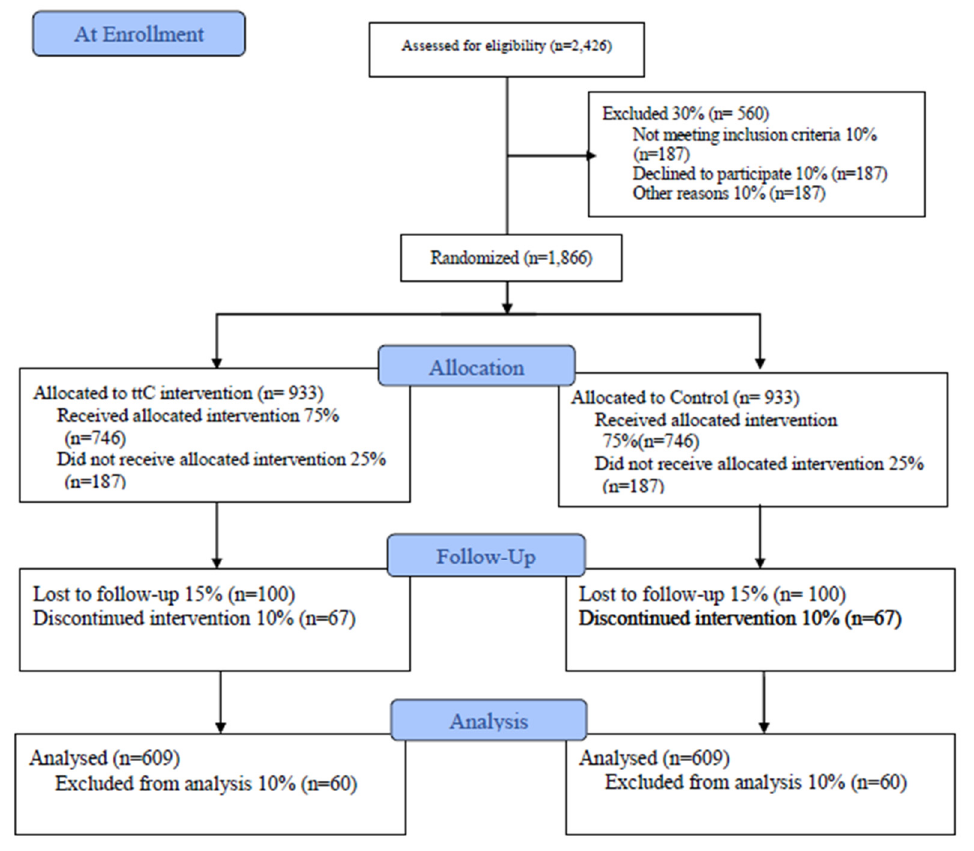
Figure 2. CONSORT flow diagram.